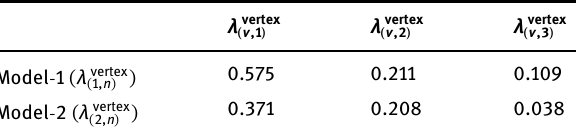
Table 2: The orders of singularities at the vertices, ( ) λ v n vertex , .